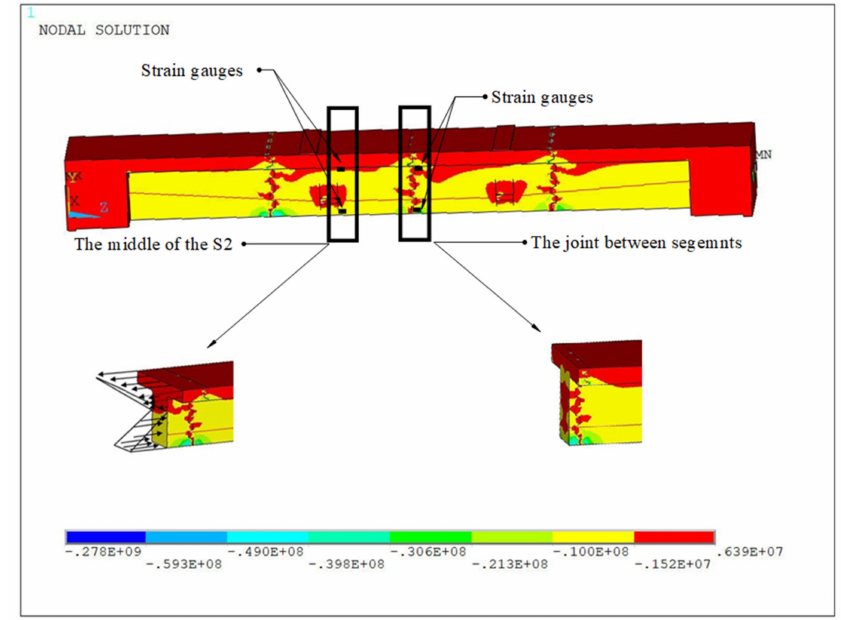
Figure 10. Longitudinal stress contours of the beam under prestress force of 107